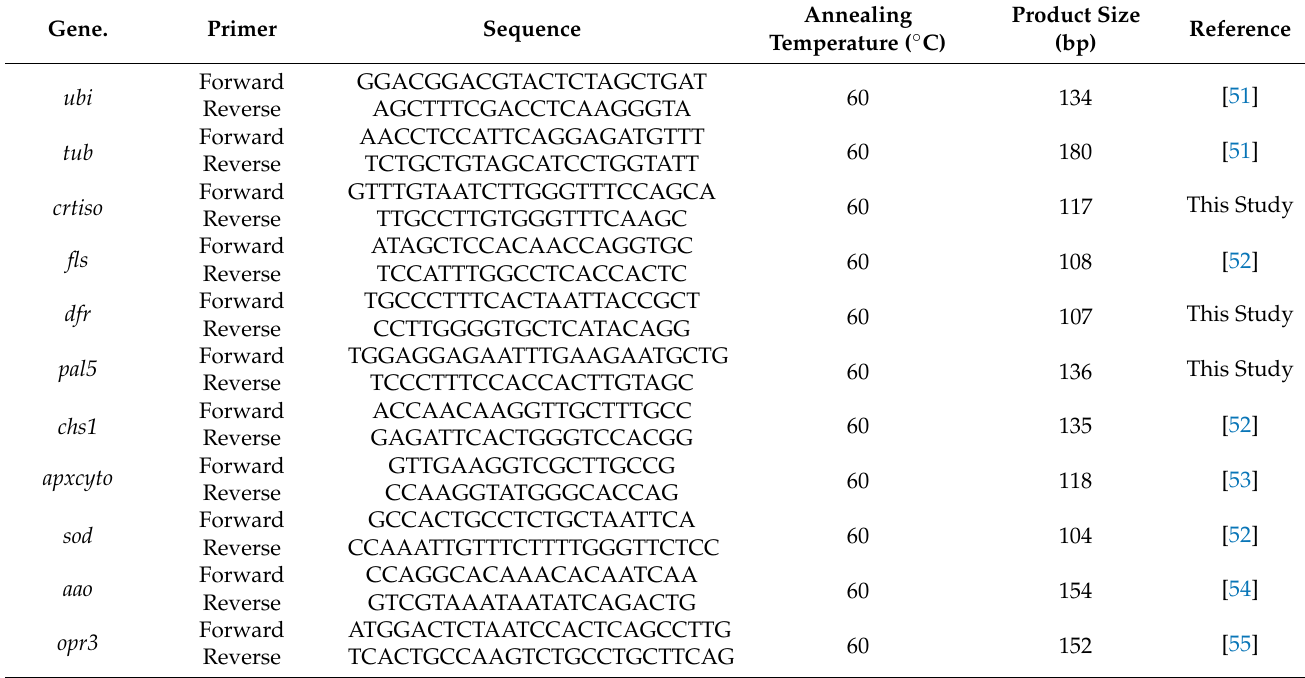
Table 1. Primers used for gene expression